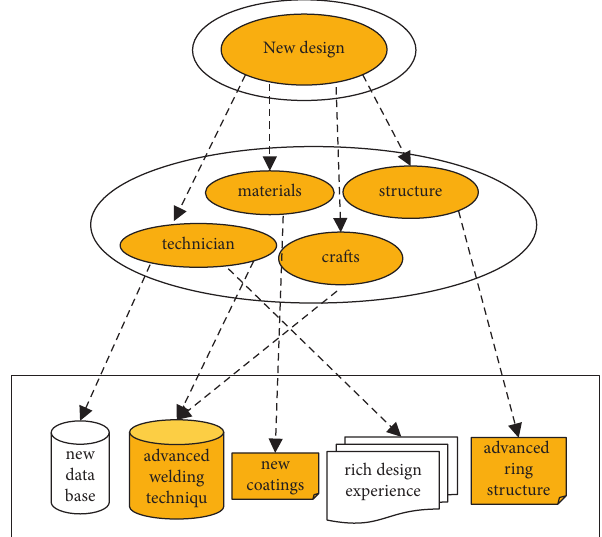
Figure 7: The knowledge map of new